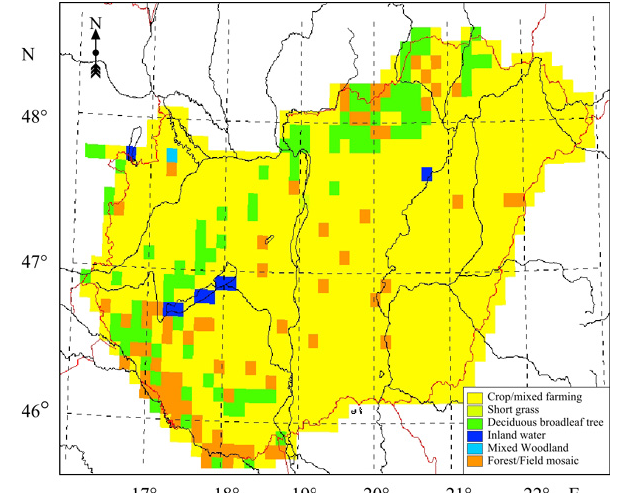
Figure 1. Land use categories over Hungary in RegCM-3 model